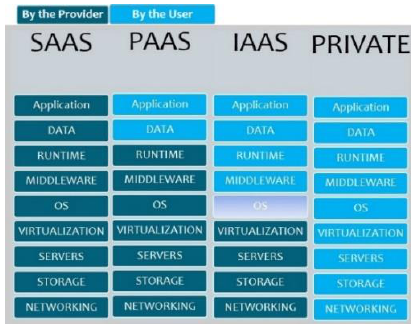
Figure 5. Security Responsibility in the Cloud (Web 17)